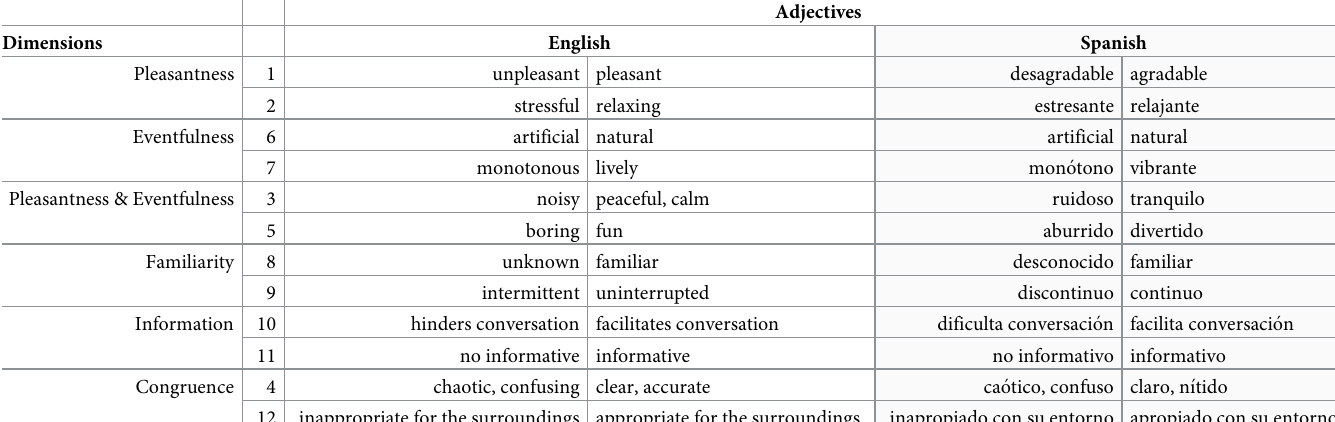
Table 1. List of the 12 bipolar adjectives of the Acoustic Comfort Assessment Scale ( ACAS-12 ) in Spanish (native language) and